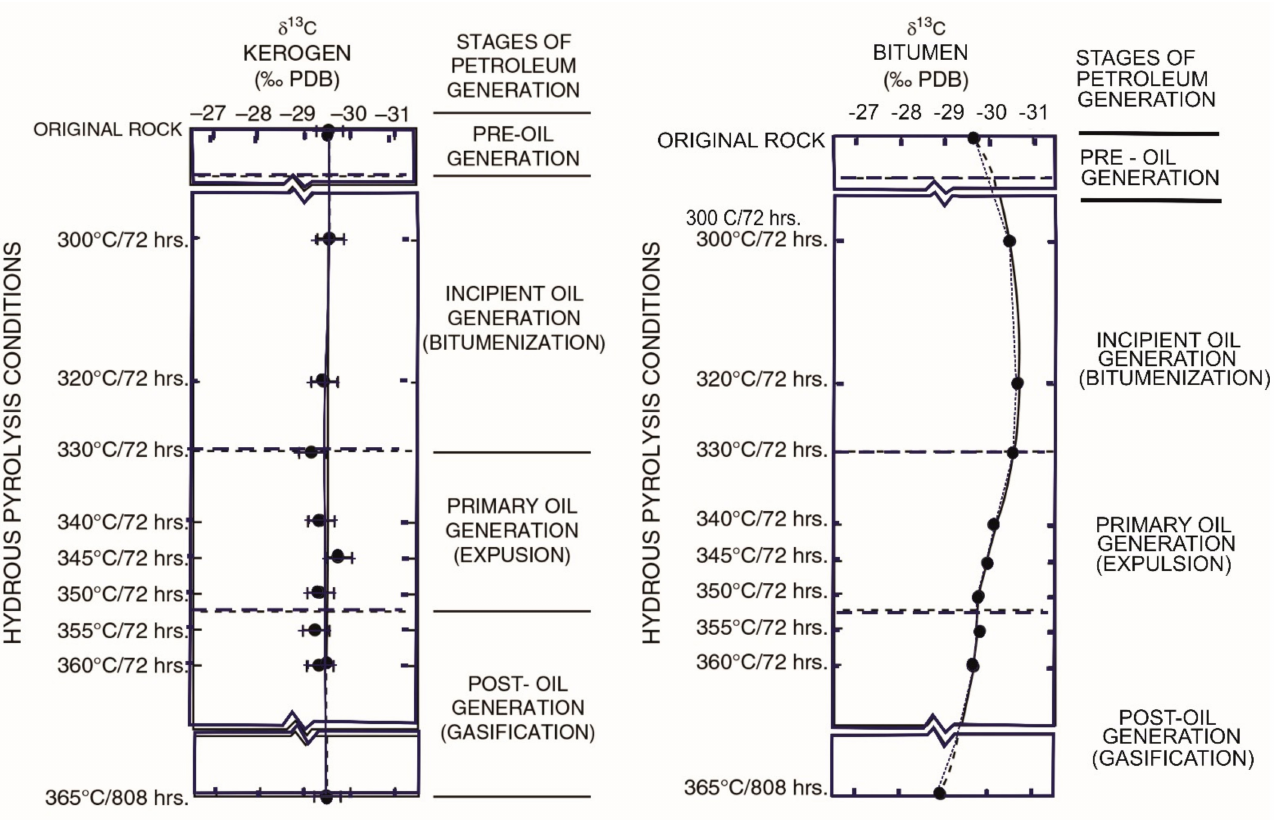
Figure 5. Changes in the isotopic compositions of crude oils and kerogen with maturation. (Repro- duced from [124] with permission from